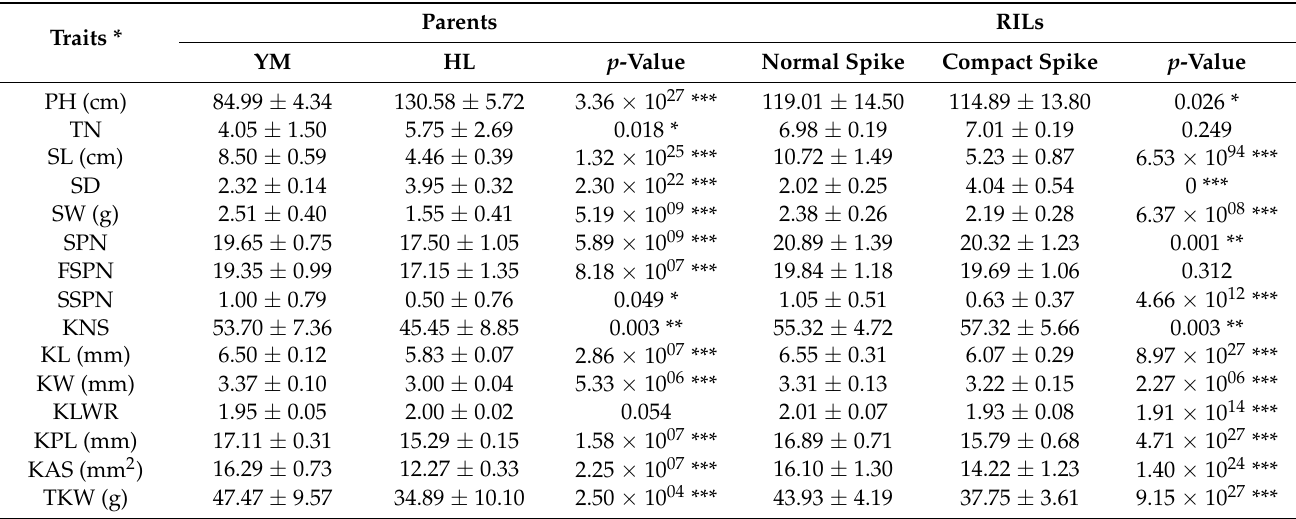
Notes: The descriptive statistics comprise mean and range for 15 traits measured from the RIL population and their parental lines YM and HL in BLUP values from four environments trials during years 2018–2021. N = 128 with normal spike density (1.49–2.80 spikelets/cm), N = 112 with a compact spike (2.99–5.26 spikelets/cm). Traits that show significant mean difference between genotypes are indicated by * p < 0.05, ** p < 0.01 or *** p <